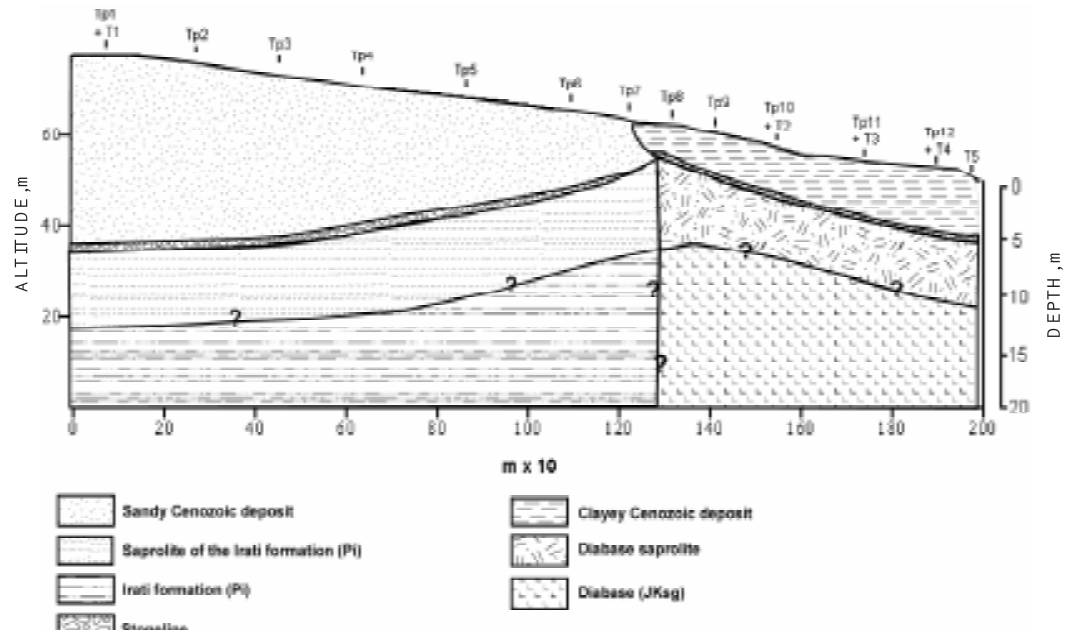
Figure 1. Soil and parent material distribution on the toposequence (T= road cuts and pits, Tp= deep auger